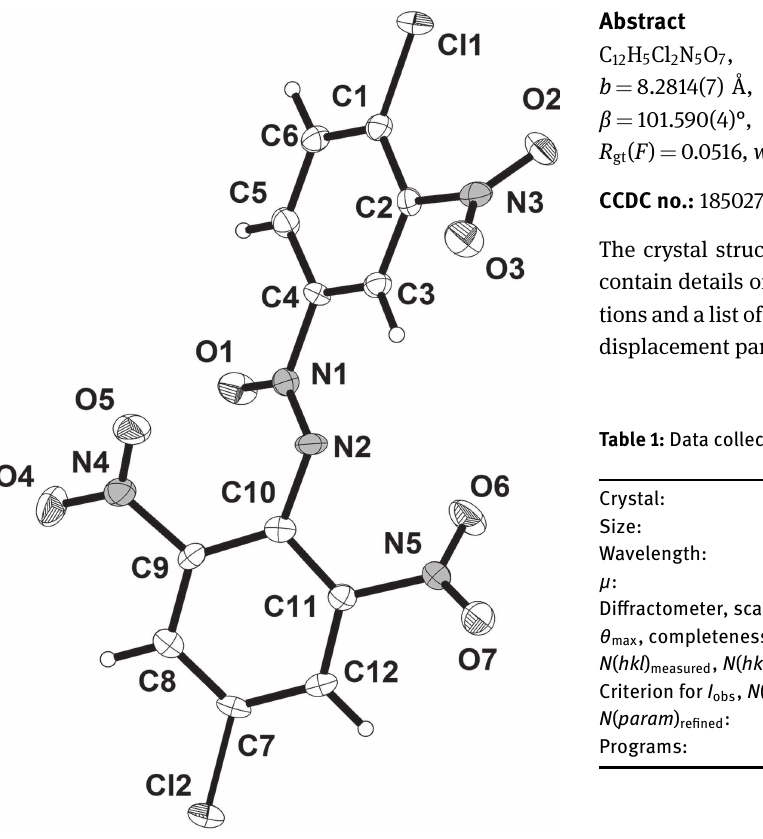
Table 2: Fractional atomic coordinates and isotropic or equivalent isotropic displacement parameters (Å 2